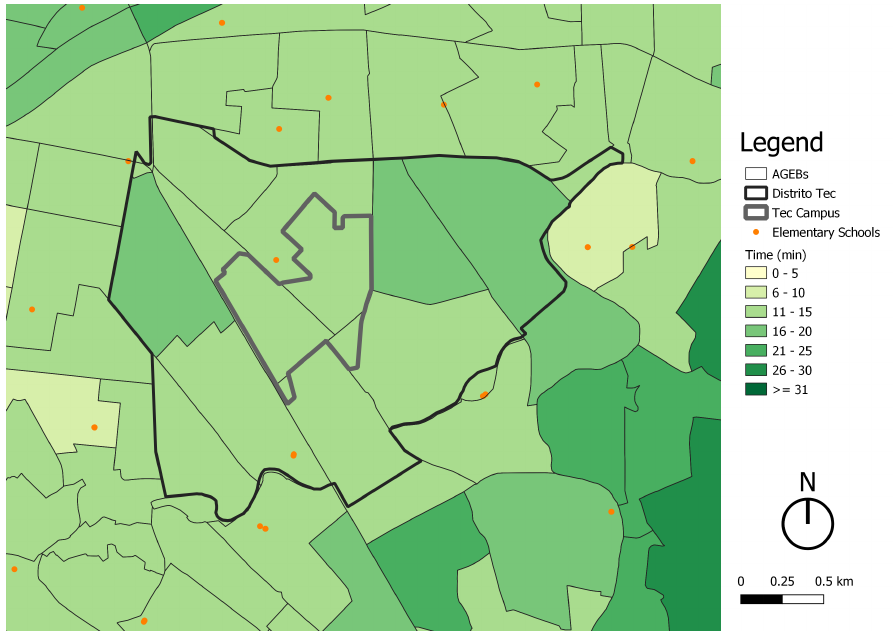
Figure 13. Distrito Tec average travel time to the 3 closest public elementary schools by foot.